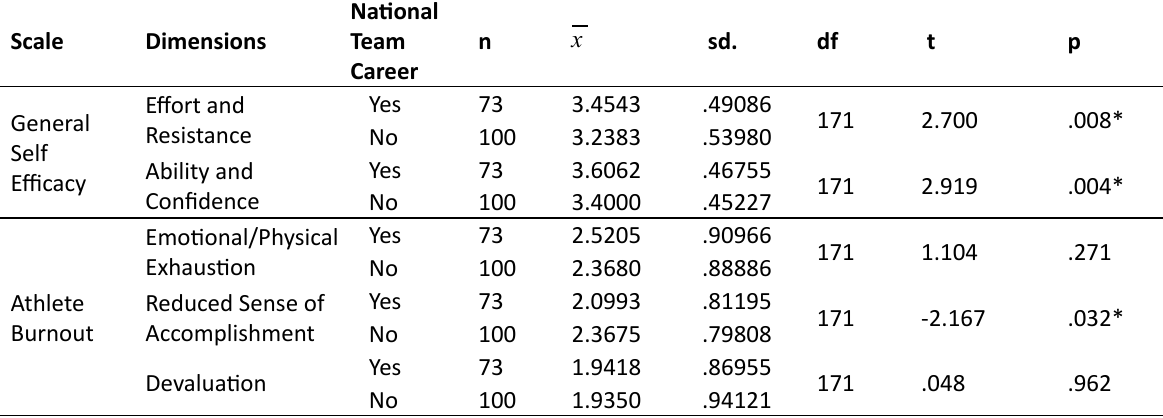
Table 6. Evaluation of general self-efficacy and athlete burnout level by national team career